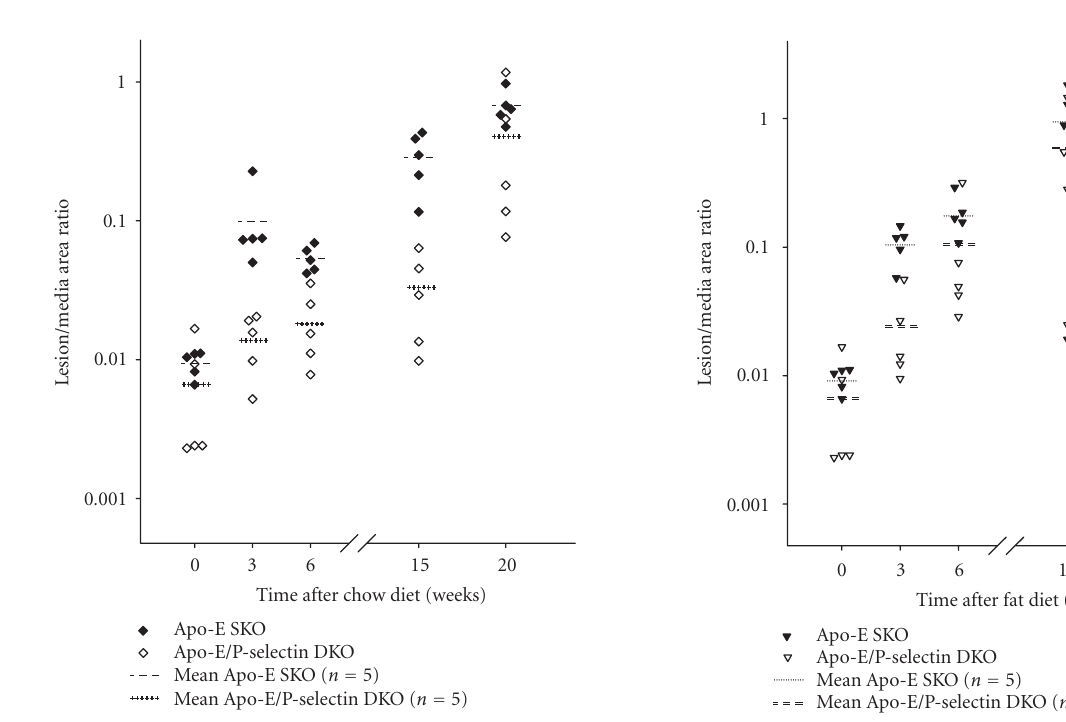
Figure 4: Lesion area in ApoE − / − (SKO) and ApoE − / − , P -Selectin − / − (DKO) mice fed a chow diet . Ratios of lesion area over media area for SKO or DKO animals fed a chow diet, over 0 to 20 weeks. Individual values and means of SKO and DKO area ratios are shown for each time.